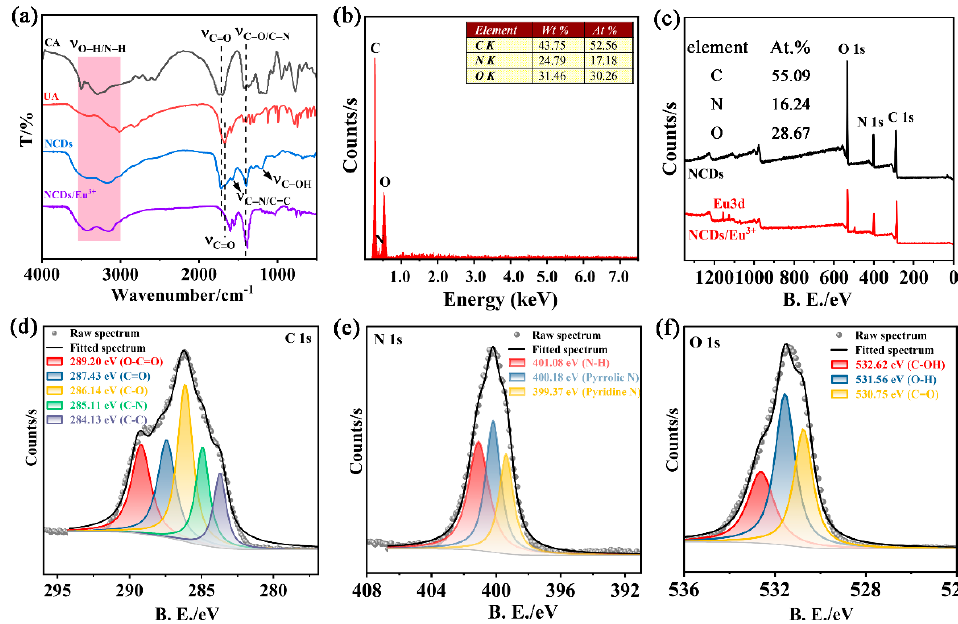
Figure 2. ( a ) FT − IR spectrum of CA, UA, NCDs and NCDs/Eu 3+ ; ( b ) EDX result of NCDs, the inset is the weight percentage (Wt %) and atomic percentage (At %) of elements; ( c ) XPS survey scan of NCDs and NCDs/Eu 3+ ; high-resolution ( d ) C1s, ( e ) N1s and ( f ) O1s spectrum of NCDs.